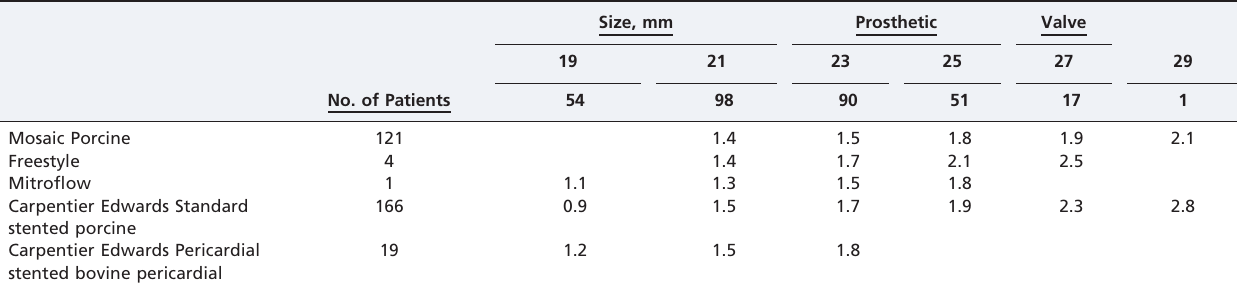
Table 3 - Reference values of effective orifice area for bioprosthetic aortic valves.